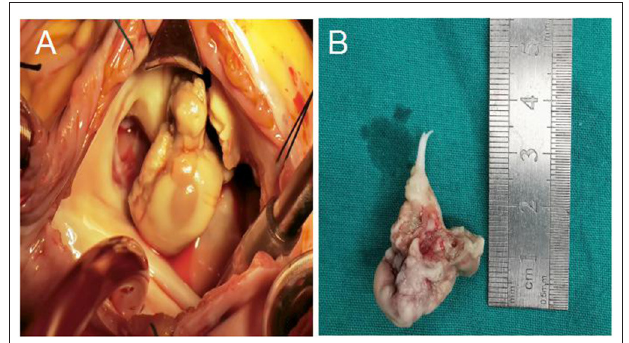
FIGURE 3 | (A) Tricuspid valve vegetations under surgical vision; (B) Some tricuspid leaflets and chordae tendineae after resection.